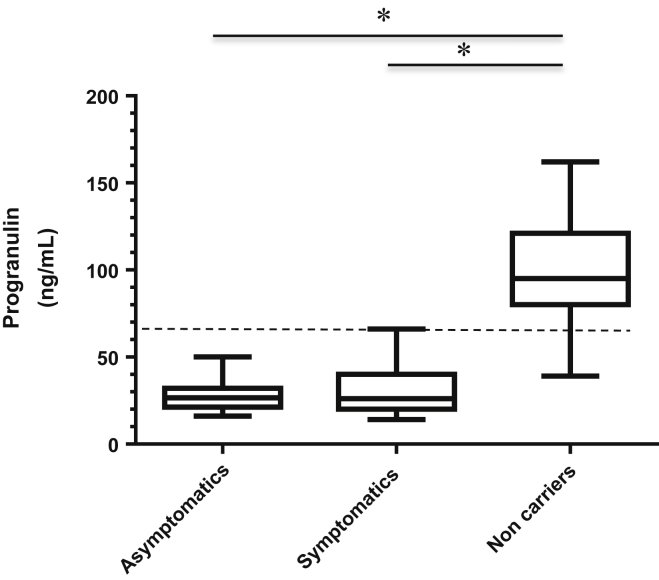
Box and whiskers plot of progranulin plasma levels. The dotted line indicates the proposed threshold (61.55 ng/mL). ∗p < 0.001.